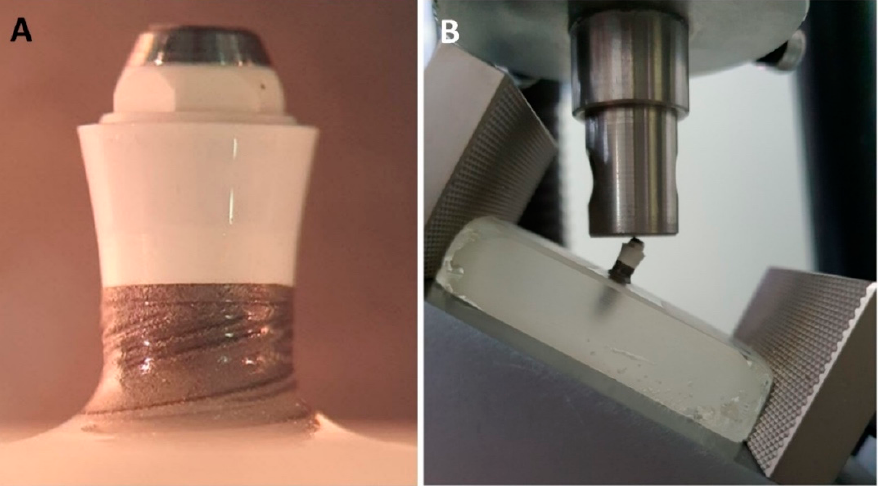
Figure 3. ( A ) Embedded specimens simulating vertical bone resorption. ( B ) Test setup for the fatigue tests.